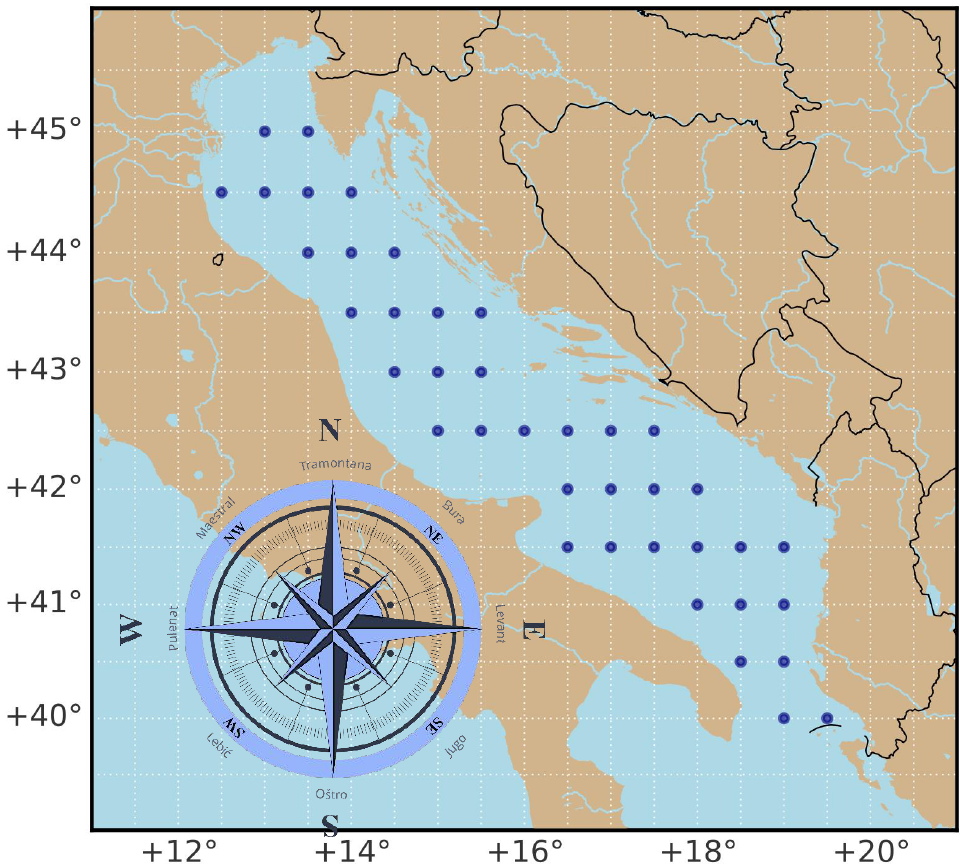
Figure 2. The Adriatic Sea map. The offshore grid of 39 blue dots denotes available locations for wave data extraction from the WWA database. Lat-lon grid resolution is 0.5 degrees. Almost all defined points are at the same time calibration points close to the satellite tracks. The wind rose is presented in the lower-left corner of the map.